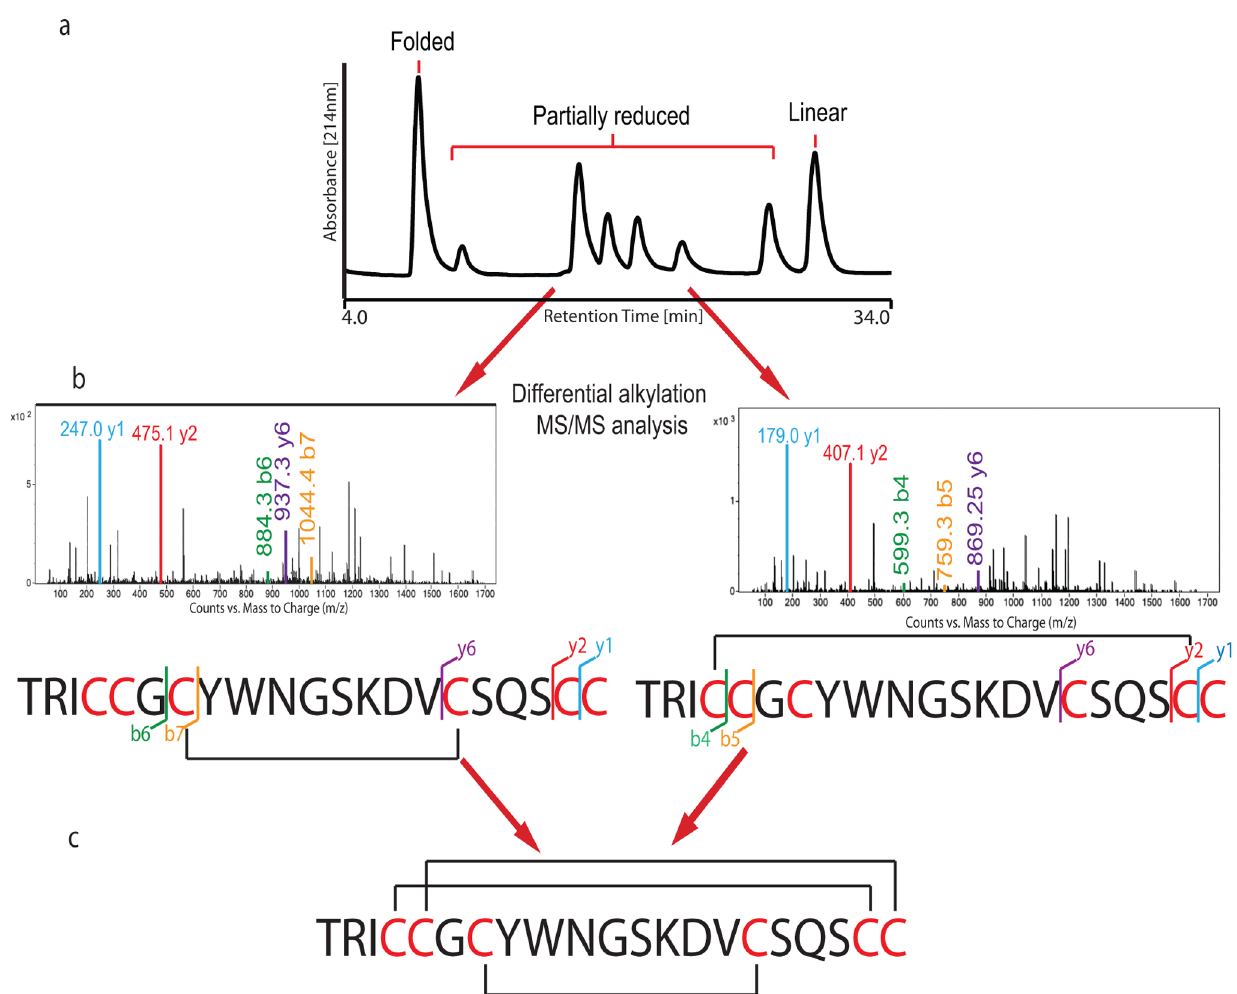
Figure 3. Disulfide mapping of Tv1. a) RP-HPLC fractionation of all differentially folded peaks (on HPLC gradient of 20% to 35% buffer B (80% Acetonitrile, 0.1% TFA) in buffer A (water, 0.1% TFA) over 75 min. b) MS-MS spectrum of partially reduced peptide peaks showing representative alkylated b and y ions. c) Schematic representation of Tv1 with predicted disulfide bridges.